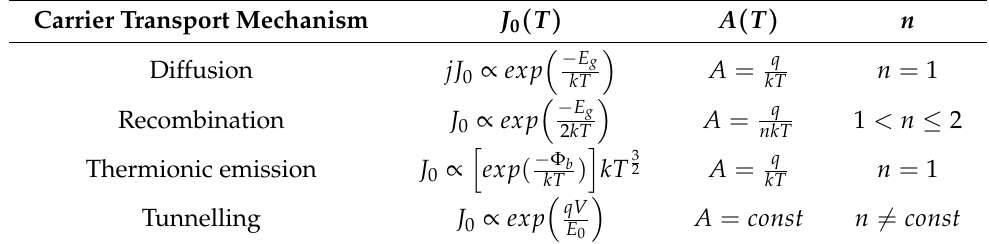
Table 2. Saturation current density J 0 , pre-exponential A parameter and ideality factor n for different basic conduction mechanisms in forward biased junction. Adapted with permission from Marsal